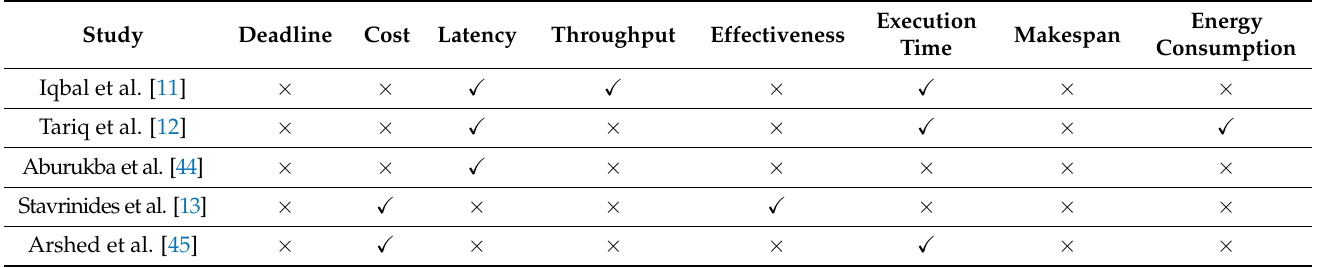
Table 19. Analysis of articles in terms of evaluation parameters in health monitoring